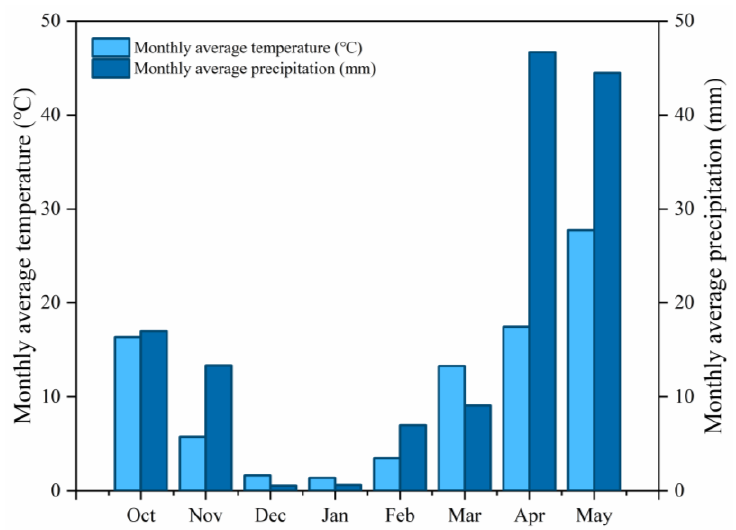
Figure 1. Total precipitation and monthly mean temperature during wheat growth stage from October 2021 to June 2022.